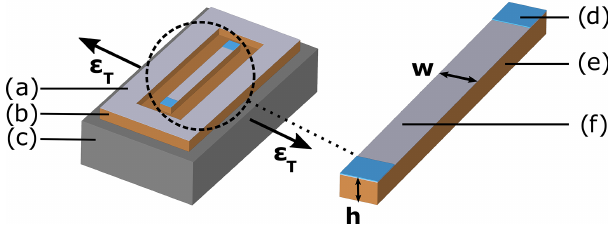
Figure 4. Model of a thin-film SG (without reverse loops) which is attached to a metal component. The geometry of the polyimide path allows us to influence the strain transfer from the metal com- ponent to the active thin film: (a) granular thin film, (b) polyimide carrier, (c) transversally strained metal component, (d) solder pad, (e) polyimide path with height h and width w , and (f) active granu- lar thin-film element (Mathis et al.,